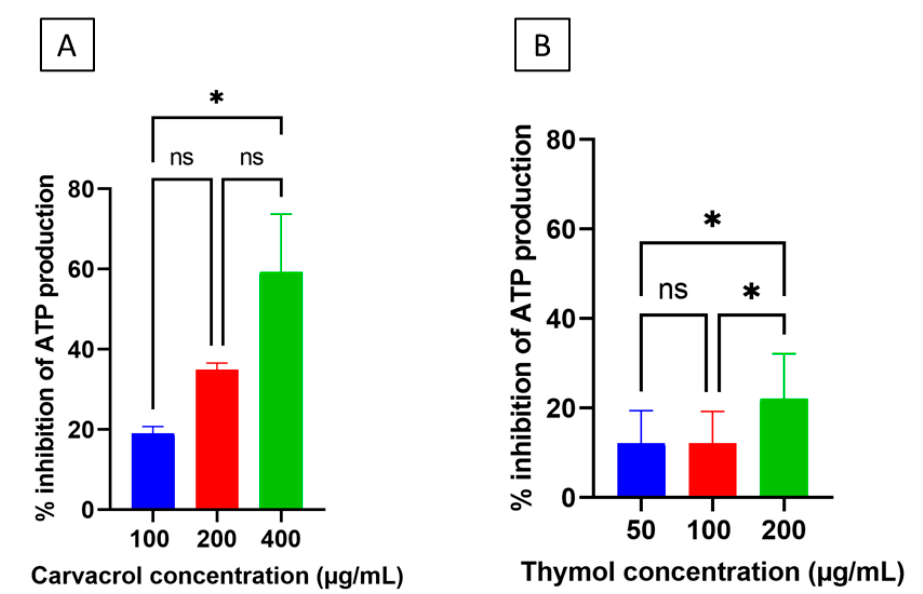
Figure 9. Inhibition of adenosine triphosphate (ATP) production in desiccation-adapted Salmonella Tennessee E2007000304 after treatment with different concentrations of carvacrol (panel ( A )) or thymol (panel ( B )) for 2.0 h at 37 °C. Each data point represents mean ± standard deviation. Asterisk (*) denotes significant difference at p < 0.05. “ns” denotes non-significant (i.e., p > 0.05). Table 1. Relative expression, determined as expression ratio *, of desiccation-related genes in desiccation-adapted Salmonella Tennessee, which was treated with carvacrol and thymol and com- pared to the untreated desiccation-adapted